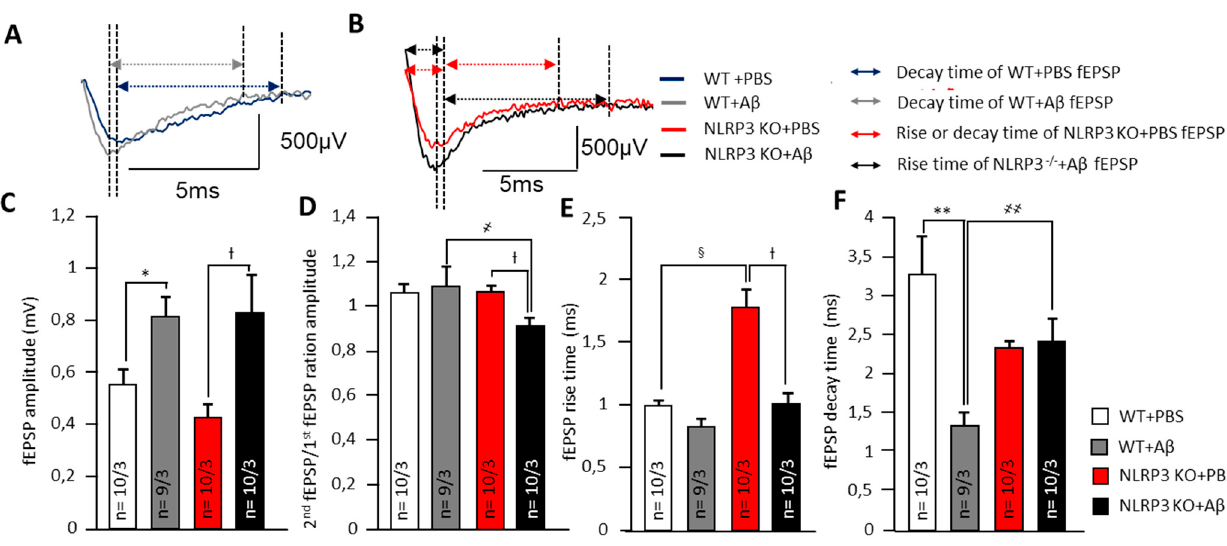
Figure 3. Alteration of synaptic transmission in synapses of amygdala neurons. ( A ) Representative traces of fEPSPs from WT animals marked with corresponding colors (blue—treated with PBS and grey treated with A β ). Arrows shows the length of rise and decay time. ( B ) Representative traces of fEPSPs from NLRP3 KO animals marked with corresponding colors (red—treated with PBS and black treated with A β ). Arrows shows the length of rise and decay time. The summary graphs show the average amplitudes ( C ) , PPF ratio (second amplitude/first amplitude fEPSP) ( D ), rise ( E ) and decay time ( F ) of fEPSPs. The groups are marked with corresponding colors. WT—wild type control mice, NLRP3 KO—NLRP3 knockout mice, A β —amyloid beta injection, PBS—phosphate buffered saline injection (sham operation). * p < 0.05; ** p < 0.01; † p < 0.05. ҂ p < 0.05; ҂҂ p < 0.01; § p < 0.05.